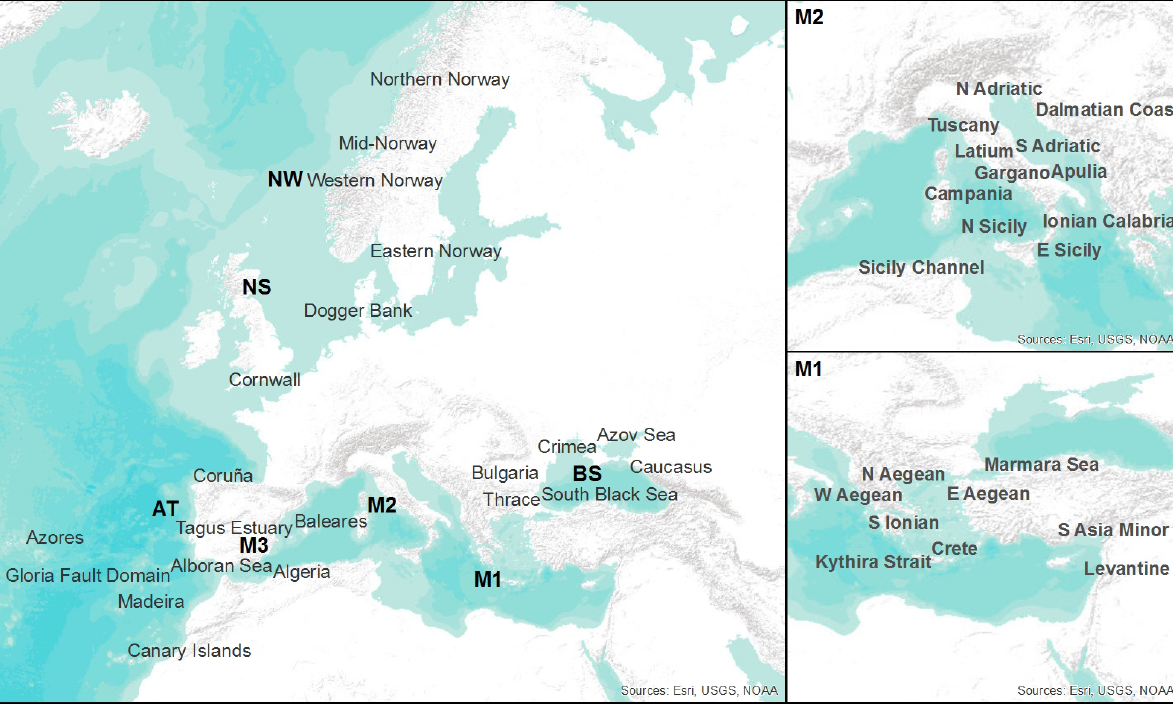
Figure 1. Geographical regions and sub-regions included in the